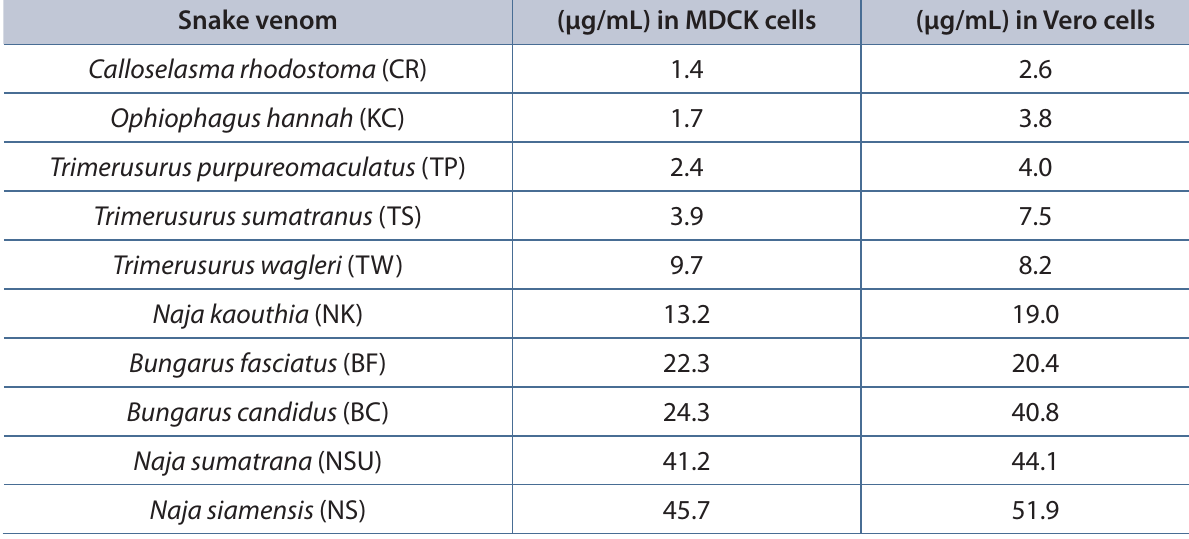
Table 1. CTC concentration (µg/mL) of snake venoms in MDCK and Vero cell lines 50 Snake venom (µg/mL) in MDCK cells Calloselasma rhodostoma